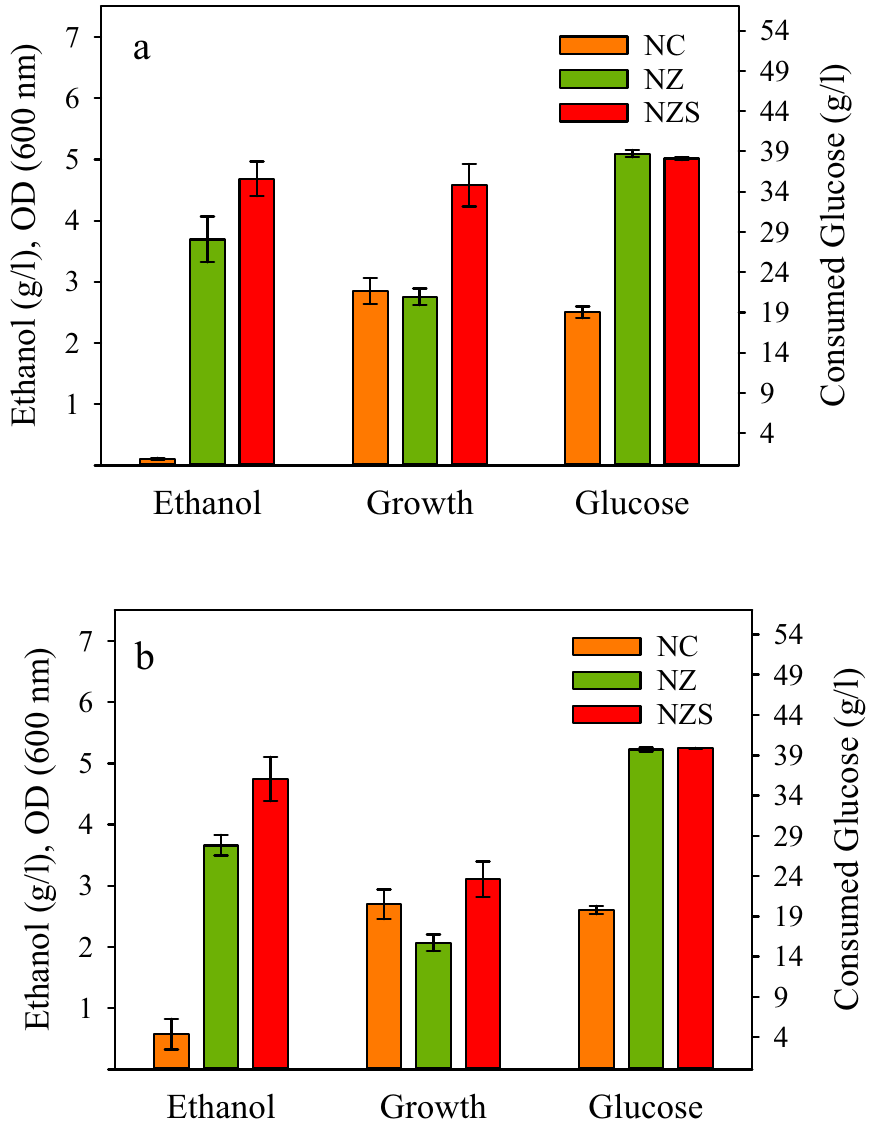
Figure 2. Ethanol production using strains NZ (Δ ldh , pdc Z -adh Z ) and NZS (Δ ldh , pdc Z -adh S ). The strains along with the control strain NC (Δ ldh ) were cultured in 2YT medium containing 40 g/L glucose at 37 °C, and 180 rpm for 96 h under limited aeration conditions. Samples were taken at ( a ) 48 h, and ( b ) 96 h of fermentation, and analyzed for ethanol production, cell growth, and glucose